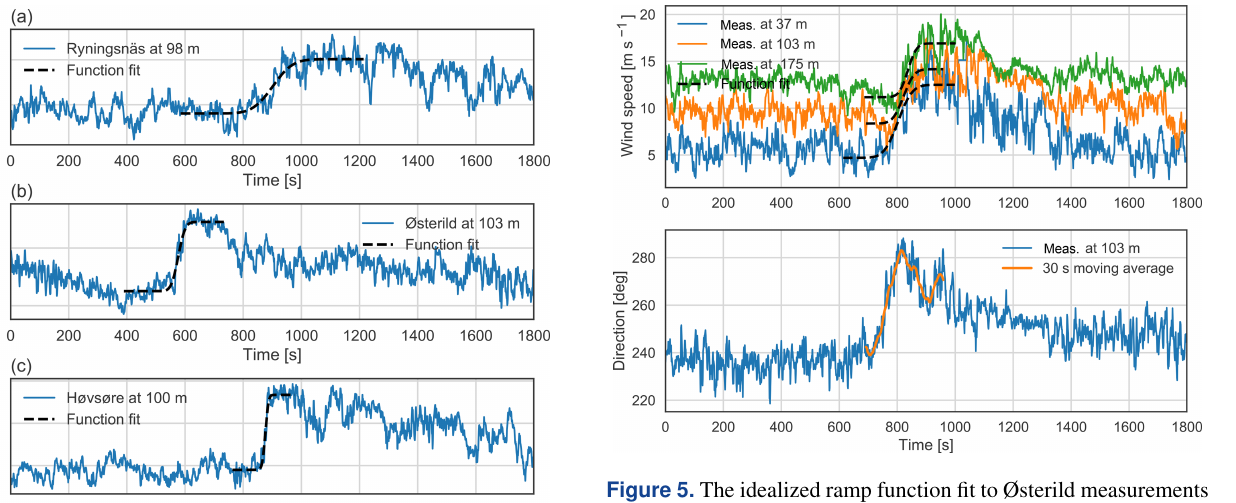
Figure 5. The idealized ramp function fit to Østerild measurements at three different heights and the corresponding direction